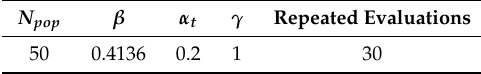
Table 3. Parameters of firefly